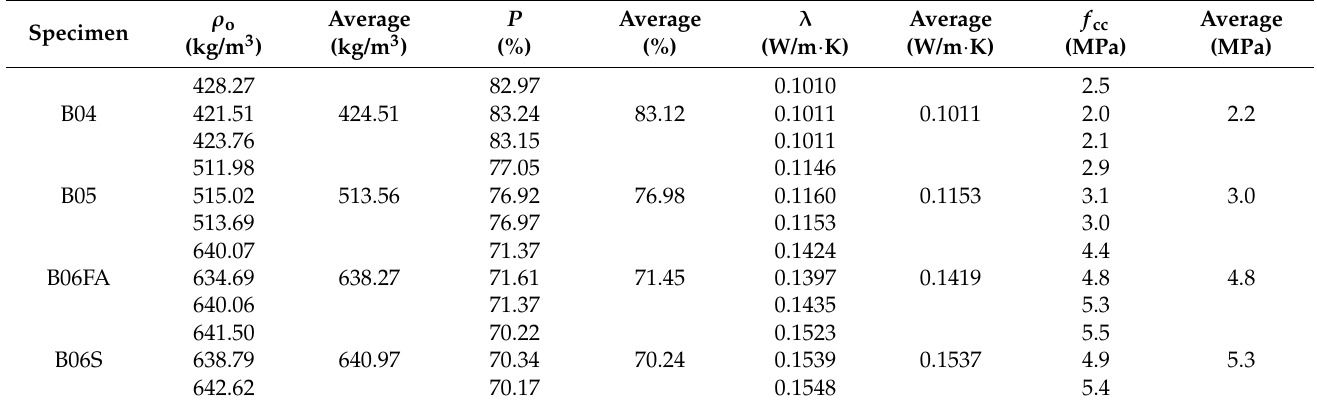
Table 7. Thermal conductivity and compressive strength of AAC.